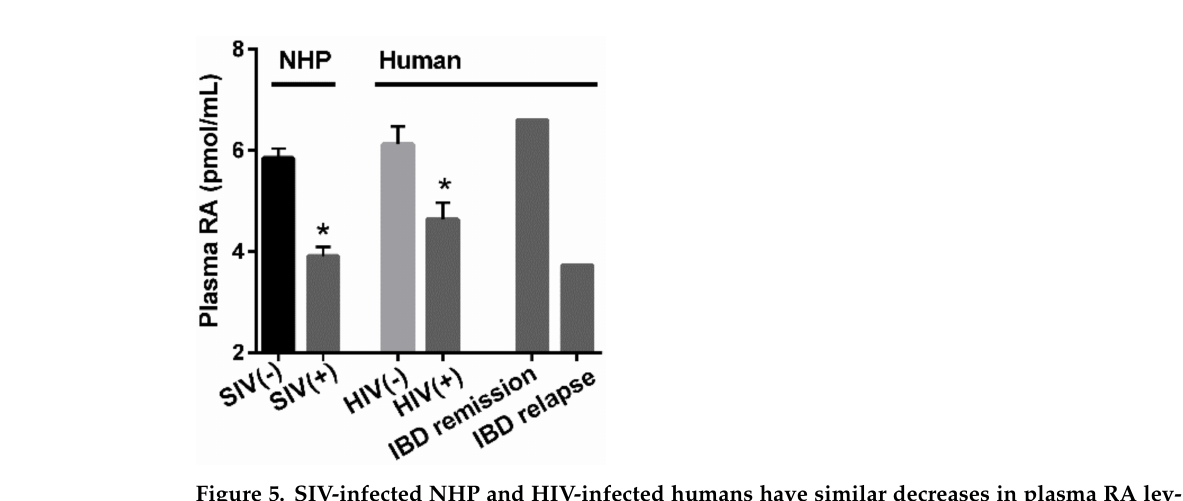
Figure 6. In vivo administration of RA to macaques with low viral loads. Monkeys were fed 10 mg/kg/day all-trans RA (orally) for 10 days, then followed for another 32 days. ( A ) Increased α 4 β 7 expression on CD4+ lymphocytes. Central memory, effector memory, and naïve CD4+ lymphocytes were gated based on their dual expression of CD28 and CD95 [4] and quantified for percent α 4 β 7 + cells. Naïve CD4 + T cells were categorized as CD28 + /CD95 − , central memory CD4 + T cells as CD28 + /CD95 + , and effector memory CD4 + T cells as CD28 − /CD95 + . Results represent the mean ± SEM of 4 monkeys. * p < 0.05, significant difference compared with baseline (day 0) values. ( B ) Repre- sentative example of a “spontaneous controller” monkey from “A” showing the correlation of plasma and rectal viral load with RA levels and expression of α 4 β 7 . Adapted from Olwenyi OA, 2020 [93].